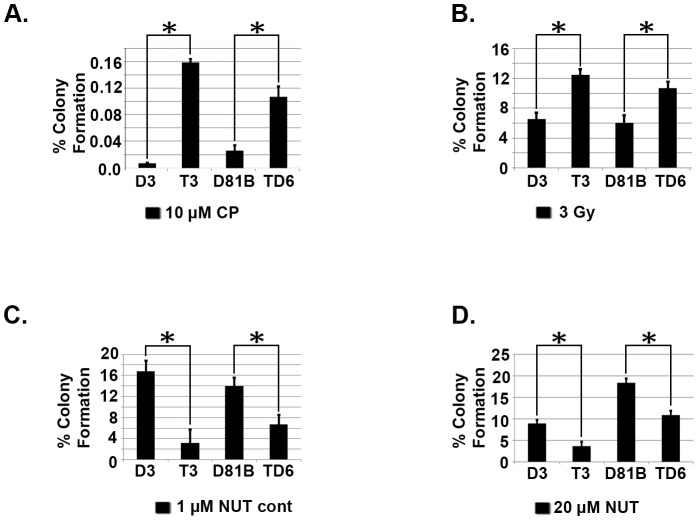
Tetraploid clones are more resistant than diploid clones to Cisplatin (CP) and ionizing radiation (IR) and more sensitive to Nutlin in a long term survival assay.
A) Diploid (D3, D81B) and tetraploid (T3, TD6) clones were untreated or treated with CP (10 µM) for 24 hrs. Cells were rinsed and re-fed with drug free media and stained after 2–3 weeks. The colonies were counted and normalized with plating efficiency of untreated controls. Shown are the mean results from three separate experiments. B) Indicated clones were untreated or exposed to IR (3 Gy). Colonies were counted 2–3 weeks later and normalized with plating efficiency of untreated controls. Shown are the mean results from three separate experiments. C) Diploid and tetraploid clones were grown in normal medium (minus Nutlin) or grown in continuous Nutlin (1 µM) and stained after 2–3 weeks. Colony number was normalized with the plating efficiency of untreated controls. D) Indicated clones were untreated or treated with Nutlin (20 µM) for 72 hrs after which the cells were rinsed and re-fed with normal medium (minus Nutlin) for 2–3 weeks. The colonies were then counted and normalized with the plating efficiency of untreated controls. Shown are the mean results from three separate experiments. bars indicate standard error (SE). * significance value (P<0.05).